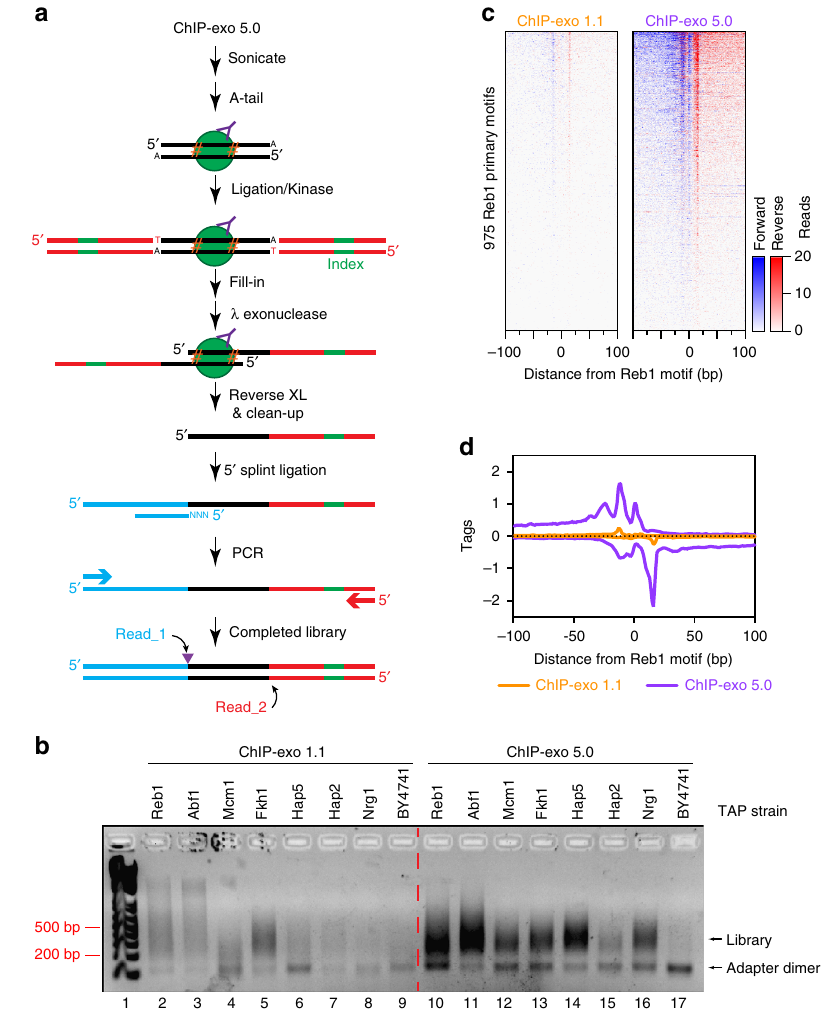
Fig. 4 ChIP-exo 5.0 increases library yield. a Schematic of ChIP-exo 5.0. The purple triangle indicates the location of the Read_1 start site, which is also the λ exonuclease stop site. b 2% agarose gel of the electrophoresed library following 18 cycles of PCR for various S. cerevisiae transcription factors assayed by ChIP-exo 1.1 or 5.0. Following ChIP, the sample was split and libraries prepared using the indicated protocols. After splitting the sample, each reaction contained a 50 ml cell equivalent (OD 600 = 0.8) of yeast chromatin, which is fi ve-fold less than the amount optimized for ChIP-exo 1.1. ChIP-exo 5.0 produced greater library yield for all samples. c Heatmaps comparing ChIP-exo 1.1 and 5.0 at the 975 Reb1 primary motifs in a 200 bp window. d Composite plot of data from panel ( c